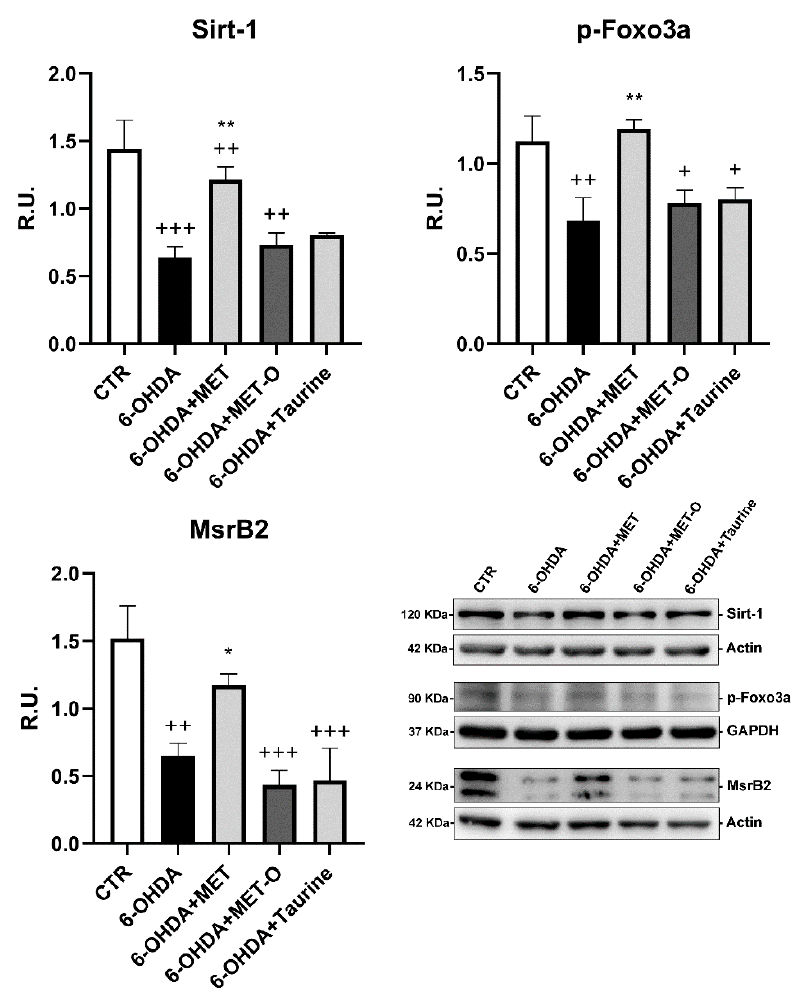
Figure 7. WB analyses for the Mrsb2 pathway. A representative WB figure is shown. Data are mean ± SD of 3 different experiments. ** p < 0.005, * p < 0.05 vs. 6-OHDA; +++ p < 0.0001; ++ p < 0.005; + p < 0.05 vs. CTR.